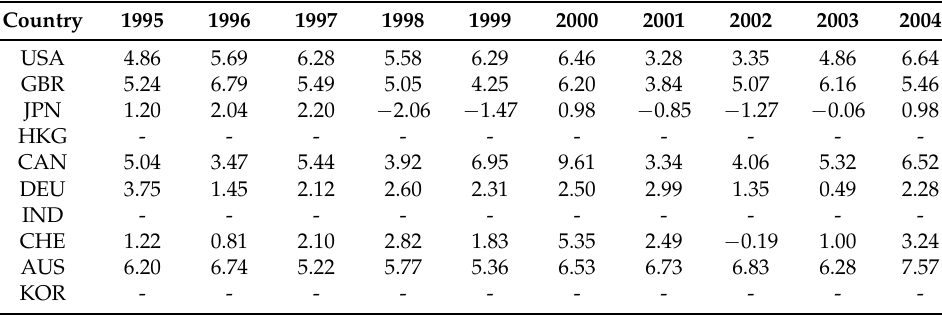
Table B2. GDP nominal growth per country ζ ( % ) :